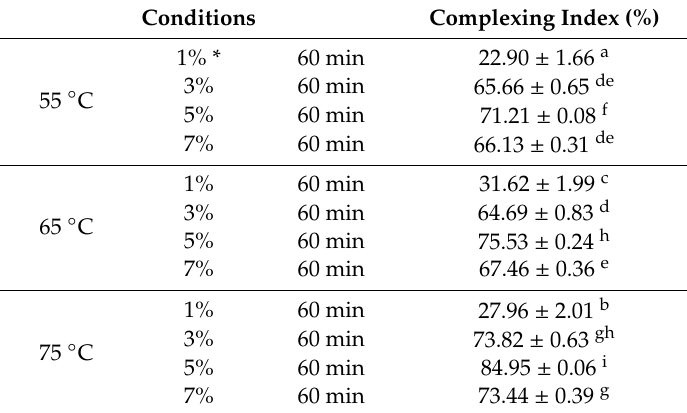
Table 2. E ff ect of the stearic acid / corn starch ratio on amylose-lipid complex